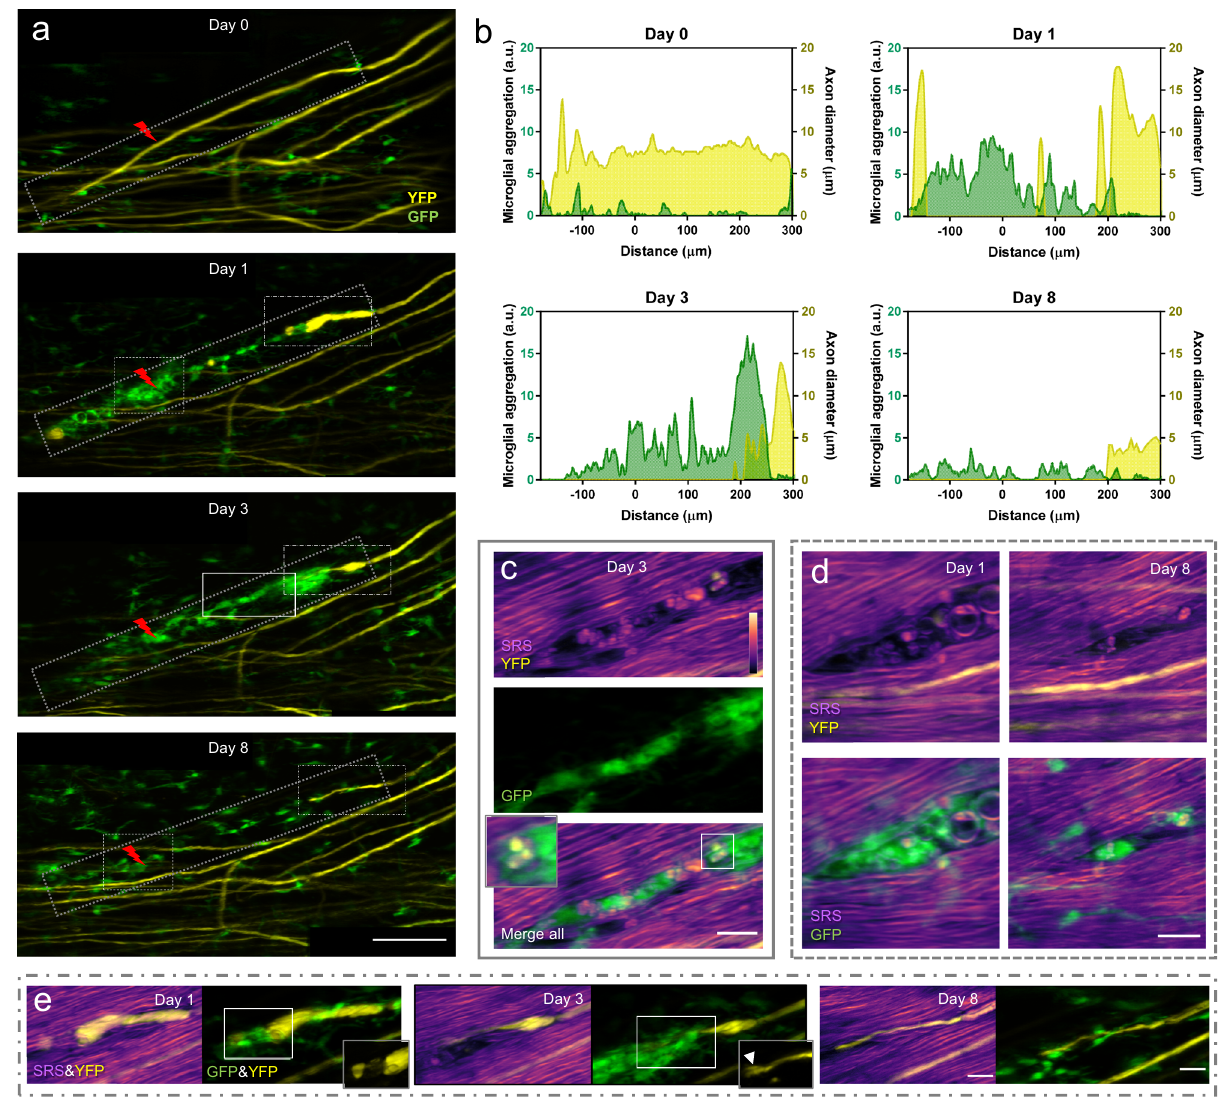
Fig. 4 In vivo multimodal NLO imaging of axonal degeneration after laser axotomy. a Maximal z intensity projections of TPEF image stacks of YFP labeled axons (yellow) and GFP labeled microglia (green) at indicated times before and after laser axotomy. The lightning bolt symbol indicates the lesion site. Scale bar, 100 μ m. b The dynamics of the distribution of microglia (green) along the axonal degeneration path and the diameter of the injured axon (yellow). Only microglial cells located in the dot rectangular region along the degenerating axon in ( a ) were included for analysis. c The multimodal image of the spinal cord in the solid box region in ( a ) shows resident microglia and/or bone marrow-derived macrophage (BMDM) aggregation along the axonal degeneration path at 3 days postinjury (dpi). Colocalization of axon (yellow) and myelin (magenta) debris and microglia (green) indicates phagocytosis of microglia/BMDMs. Insets, a zoomed-in view of myelin and axon debris colocalized with microglia/BMDMs. d The multimodal images taken at 1dpi and 8 dpi in the dashed box region in ( a ) show the initialization and fi nalization of debris clearance, respectively. e The zoomed-in multimodal images of the axonal proximal end at indicated time points. The imaging area corresponds to the long dash-dot box region in ( a ). For clear visualization, the merged SRS and YFP images are shown as a single slice, while the merged GFP and YFP images are shown as the maximum z projections of image stacks. Insets, YFP images of the axonal proximal end. The arrowhead denotes small sprouts emerging from the tip of the axon. SRS images of myelin were taken at Raman shift of 2863.5 cm − 1 . Scale bars in ( c – e ), 20 μ m. A.u., arbitrary units. Source data are provided as a Source Data fi